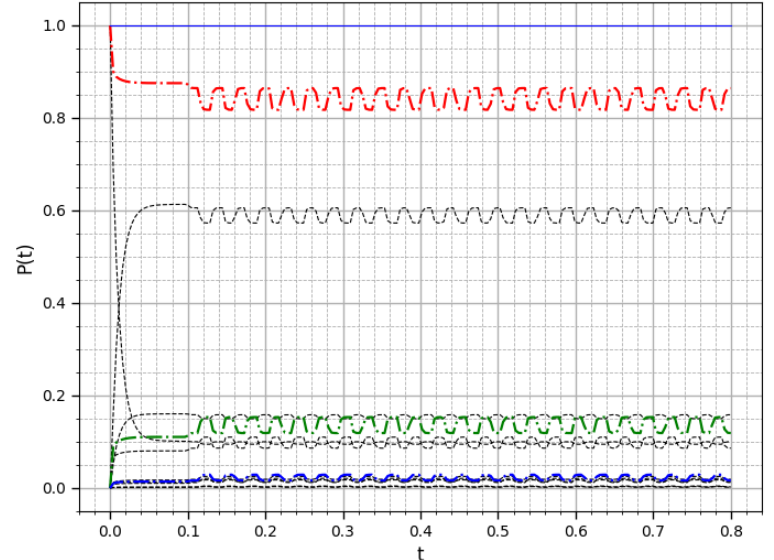
Figure 8. Dependencies of the probabilities of states with a periodic abrupt change in the arrival intensity ( λ 1 = 10 packets/s and λ 2 = 50 packets/s, t 1 = 0.015 s, t 2 = 0.015